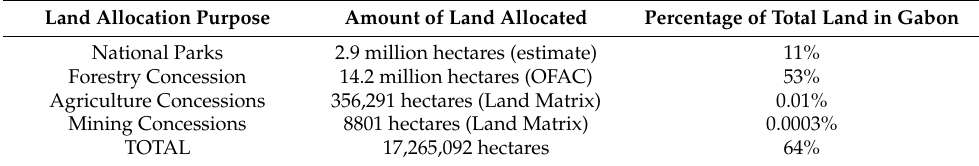
Table 1. Our findings of land allocation in